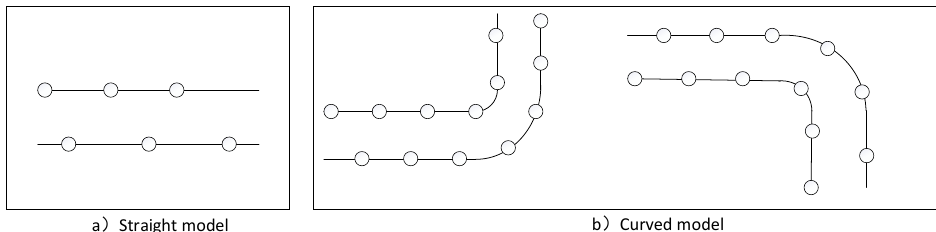
Figure 7. Typical deployment scenarios of base stations in field.